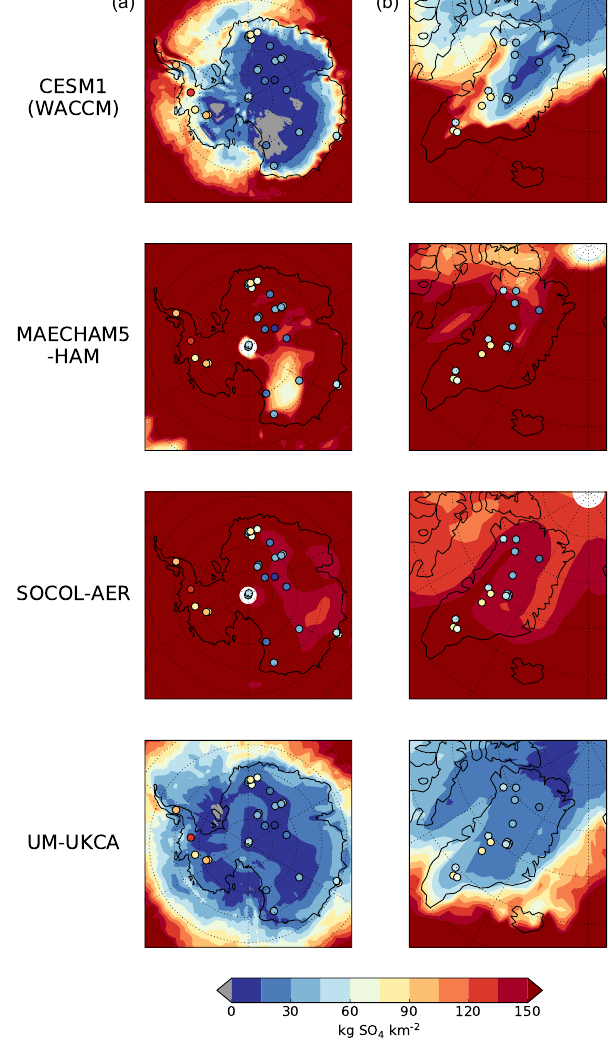
Figure 6. Cumulative deposited sulfate (kgSO 4 km − 2 ) integrated over the whole duration of model simulation ( ∼ 5 years) on Antarc- tica (a) and Greenland (b) for each model (ensemble mean). Ice core cumulative deposited sulfate values are plotted as coloured cir- cles. Ice cores from adjacent sites or in close proximity (Table S1) have been slightly relocated to avoid cores completely overlapping. Scaled versions for MAECHAM5-HAM and SOCOL-AER are in- cluded in the Supplement (Fig.